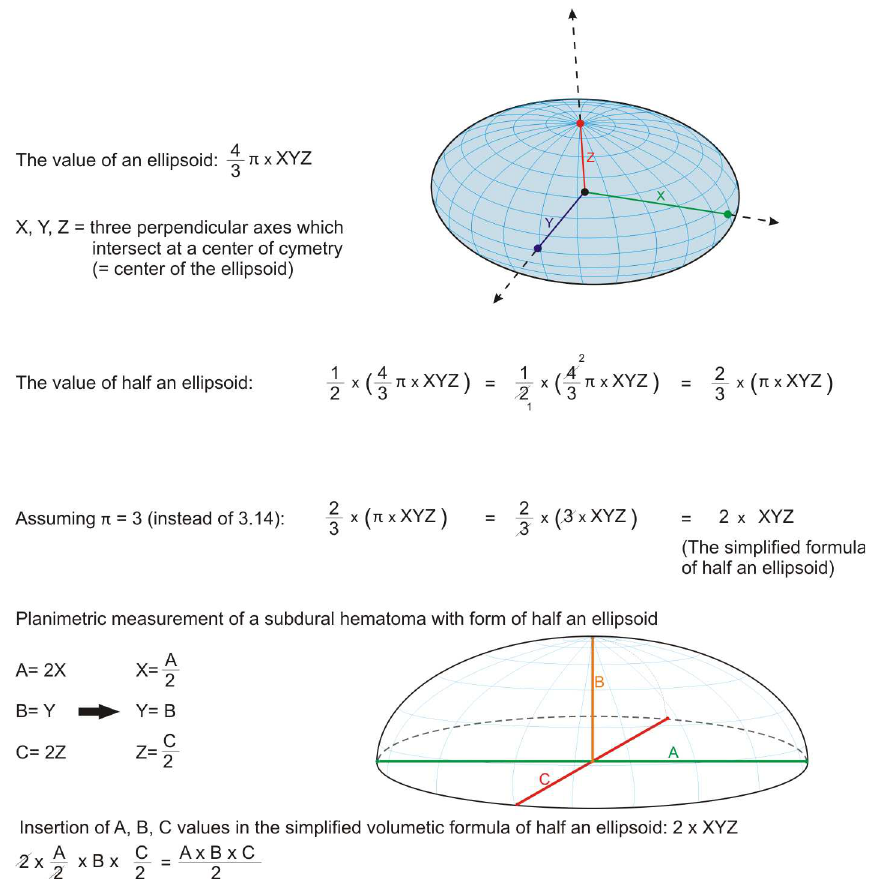
Fig 3. Mathematical derivation of the ABC/2 formula from a half ellipsoid volumetric